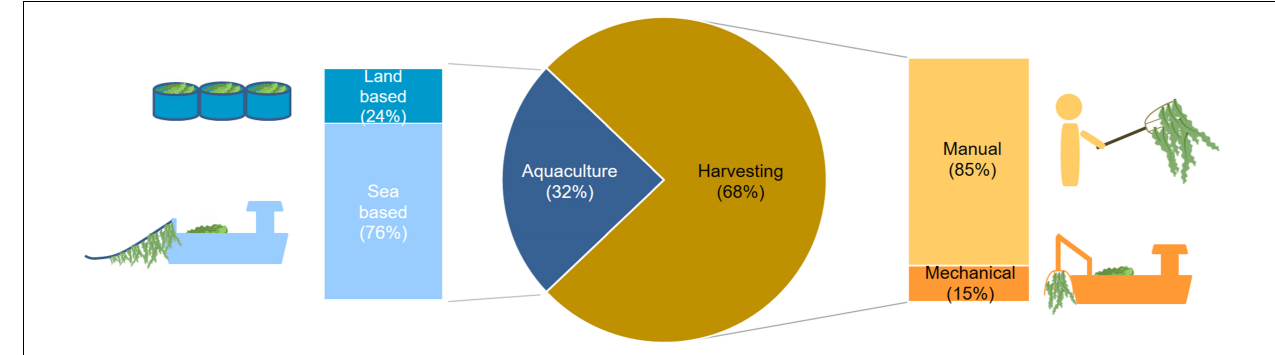
FIGURE 6 | Macroalgae production methods in Europe (share by the number of companies using these